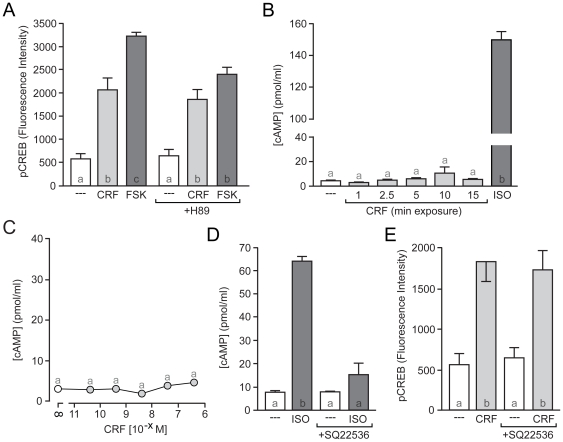
CRF-induced CREB phosphorylation occurs independently of the AC/cAMP/PKA pathway.(A) A PKA-specific concentration of the protein kinase inhibitor H89 (2 µM) failed to block CRF-induced CREB phosphorylation, but attenuated forskolin (FSK)-induced CREB phosphorylation (F = 35.78). (B) In the presence of the phosphodiesterase inhibitor IBMX (75 µM), CRF (40 nM) failed to increase cAMP during the time-course in which it increases pCREB. The β-adrenergic receptor agonist isoproterenol (ISO; 10 µM) was used as a positive control (F = 3226). (C) Several concentrations of CRF up to and including 400 nM failed to increase cAMP accumulation (in the presence of IBMX). (D) Inhibiting AC activity with SQ22536 (90 µM) completely blocked ISO-induced cAMP accumulation (F = 101.4). (E) Inhibition of AC with SQ22536 had no effect on CRF-induced CREB phosphorylation (F = 17.10).